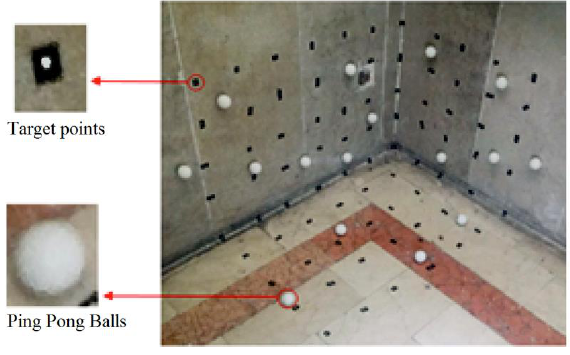
Figure 1. The photogrammetric test